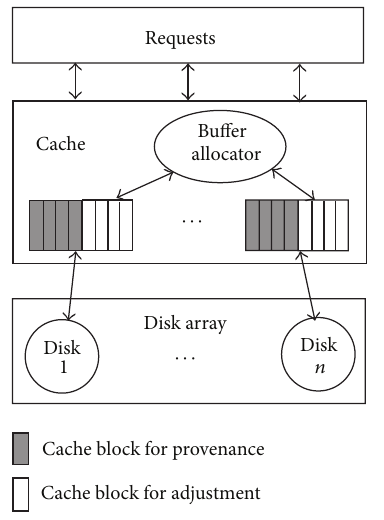
Figure 2: The high-level architecture of our